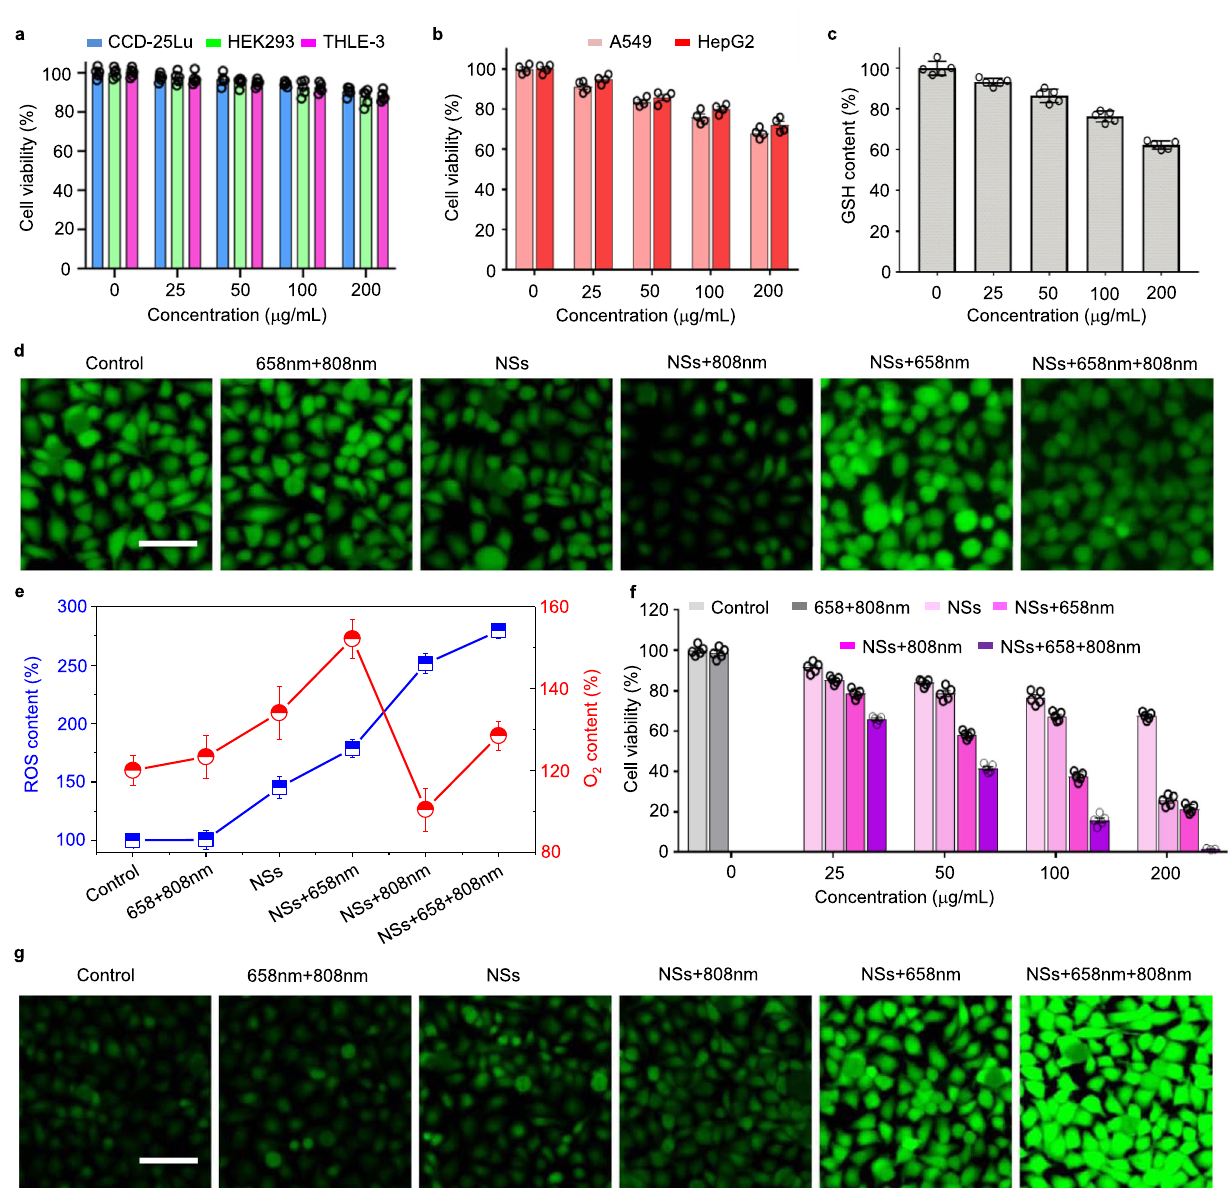
Fig. 5 In vitro photo-enhanced chemodynamic, photodynamic, and photothermal therapy. a Normal (CCD-25Lu, HEK 293, and THLE-3) and b cancer cells (A549 and HepG2) viability treated with FCL-PEG NSs at different concentrations for 24 h. The data show mean ± s.d., n = 5 biologically independent cells. c GSH content of HepG2 cells treated with FCL-PEG NSs at different concentrations for 24 h. The data show mean ± s.d., n = 5 biologically independent cells. d CLSM images of O 2 evolution of HepG2 cells treated with FCL-PEG NSs with or without 658 and 808 nm laser irradiation. Three times each experiment was repeated independently with similar results. e ROS and O 2 content of HepG2 cells under different treatments. The data show mean ± s.d., n = 3 biologically independent cells. f CLSM images of ROS generation treated with FCL-PEG NSs with or without 658 and 808 nm laser irradiation. Three times each experiment was repeated independently with similar results in all these fi gures. g Antitumor effect of FCL-PEG NSs at different concentrations. The data show mean ± s.d., n = 5 biologically independent cells. Scale bars, 50 μ m for all